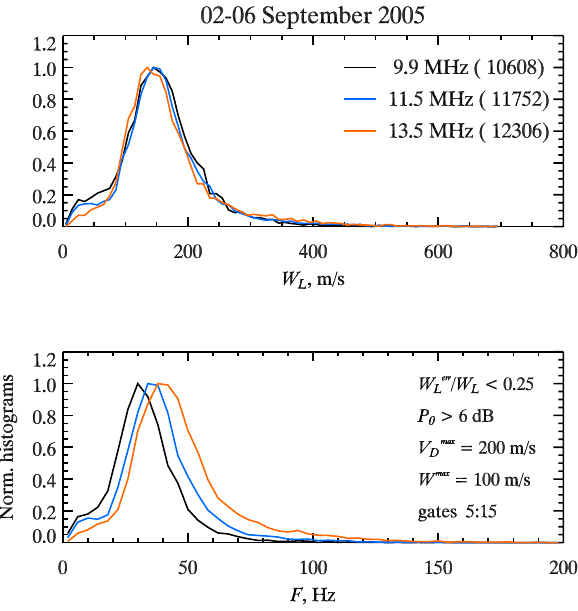
Fig. 10. Normalized E-scatter (gates 5–15) histograms for 2–6 September